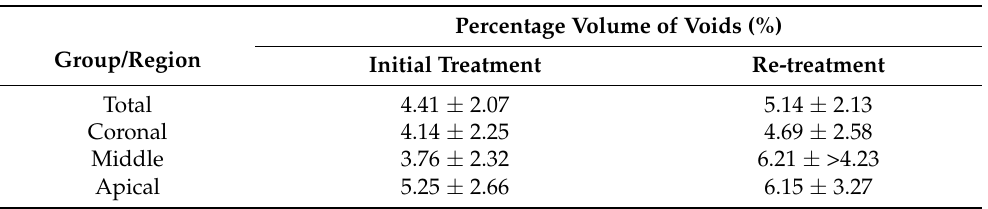
Table 4. Percentage volumes of voids (mean ± standard deviation) after obturation during initial treatment and re-treatment in the whole canal and in each third.